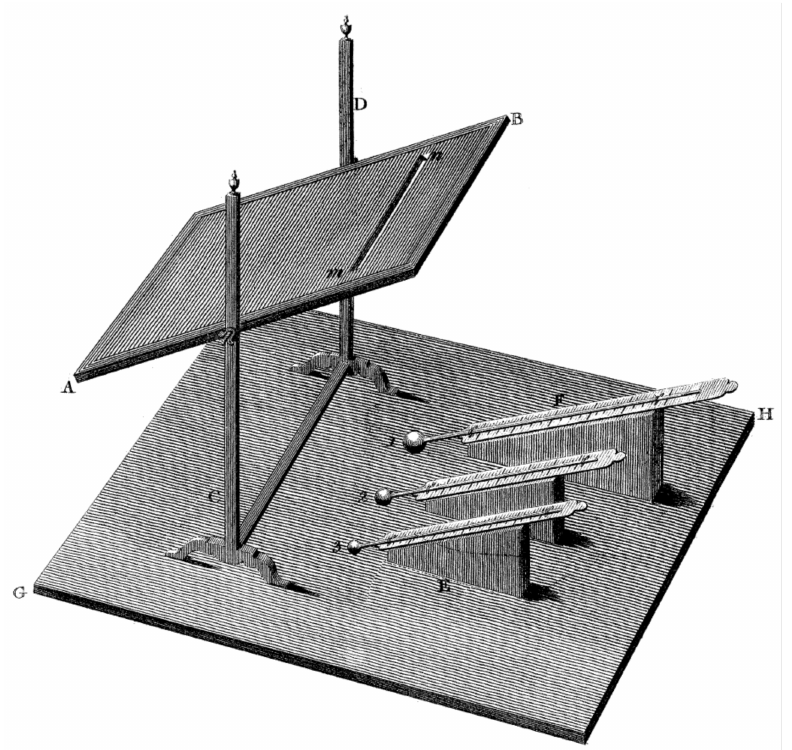
Figure 4. Measurement stand for the investigation of the value of influence of individual colours of split sunlight on the heating of objects—original drawing of the measurement stand [9]. Piece of pasteboard AB (plate X) in a frame, mounted upon a stand CD and moveable upon two centres; mn— an opening in the pasteboard, a little larger than the ball of thermometer; EF—three thermometers 1, 2 and 3 upon small inclined planes upon a small plain board